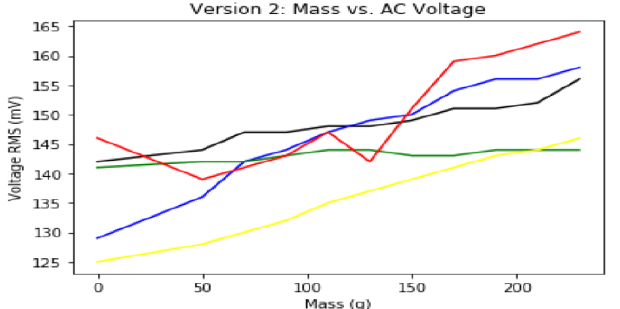
Figure 2 . Voltage RMS vs Mass for each of the Version 2 EAPs.